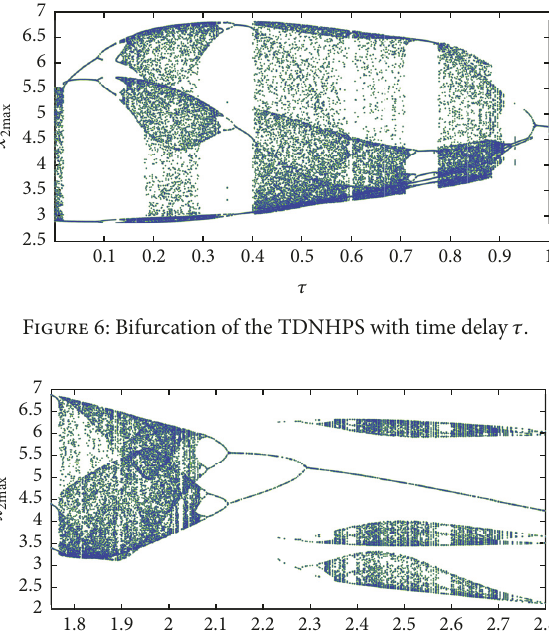
Figure 10: Bifurcation of the TDAHPS with parameter 𝜔 𝜏 .